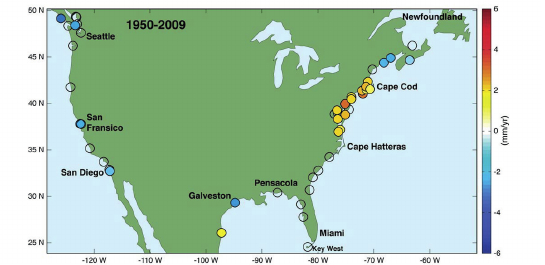
Fig. 1. Differences in rates of sea-level rise from tide-gauge records across North America over a 60-year period 1950 – 2009 (from [1]). Circles are color coded to reflect computed differences; no color fill indicates differences in rates of sea-level rise that are not statisti- cally different from zero. Cool colors indicate decreasing rates of sea-level rise over the 60-year period; warm colors indicate increas- ing rates of sea-level rise over the 60-year period. Note “hotspot” between Cape Hatteras and Cape